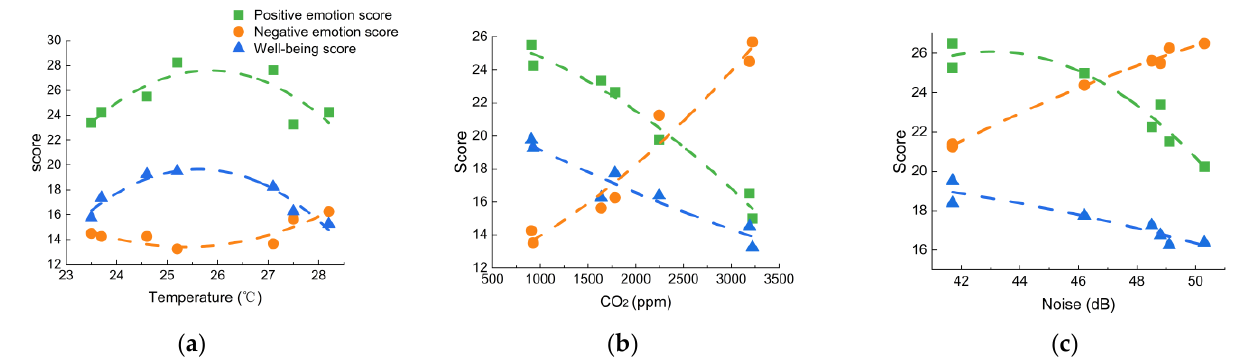
Figure 14. Associations of ( a ) temperature, ( b ) CO 2 , and ( c ) noise with emotion and well-being index scores.